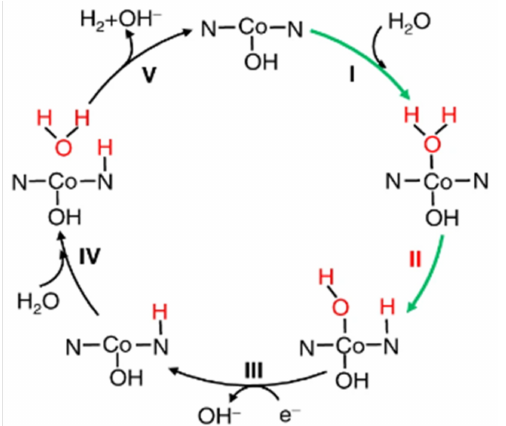
Figure 13. Alkaline HER mechanism on HO-Co 1 /PCN. I: the catalytic cycle is initiated by adsorption of H 2 O onto Co; II: dissociation into adsorbed OH* and H* on the Co and nearby N, respectively (the asterisk denotes the adsorption site); III–V: another proton from an adjacent H 2 O molecule will react with the first H* to generate H 2 . It is well known that in alkaline HER, the first sluggish Volmer step is catalytic dissociation of a water molecule with the generation of H* (H 2 O + e − = H* + OH − ). Adapted with permission from ref. [156]. Copyright 2018 Springer